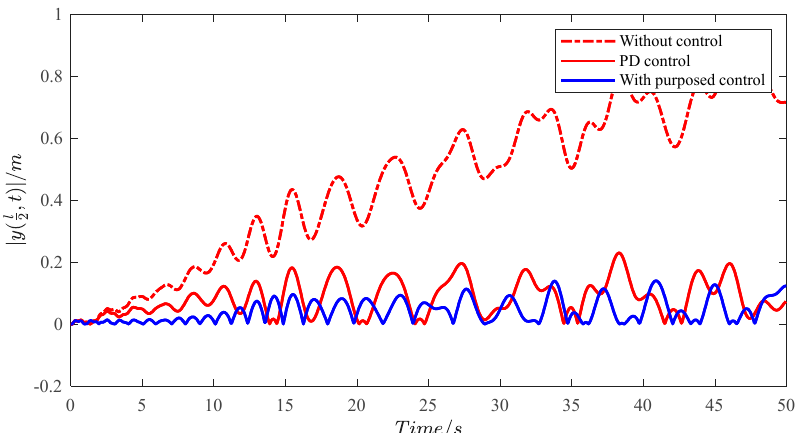
Figure 4. Absolute value of vibration at midpoint of the umbilical cable with different controllers.